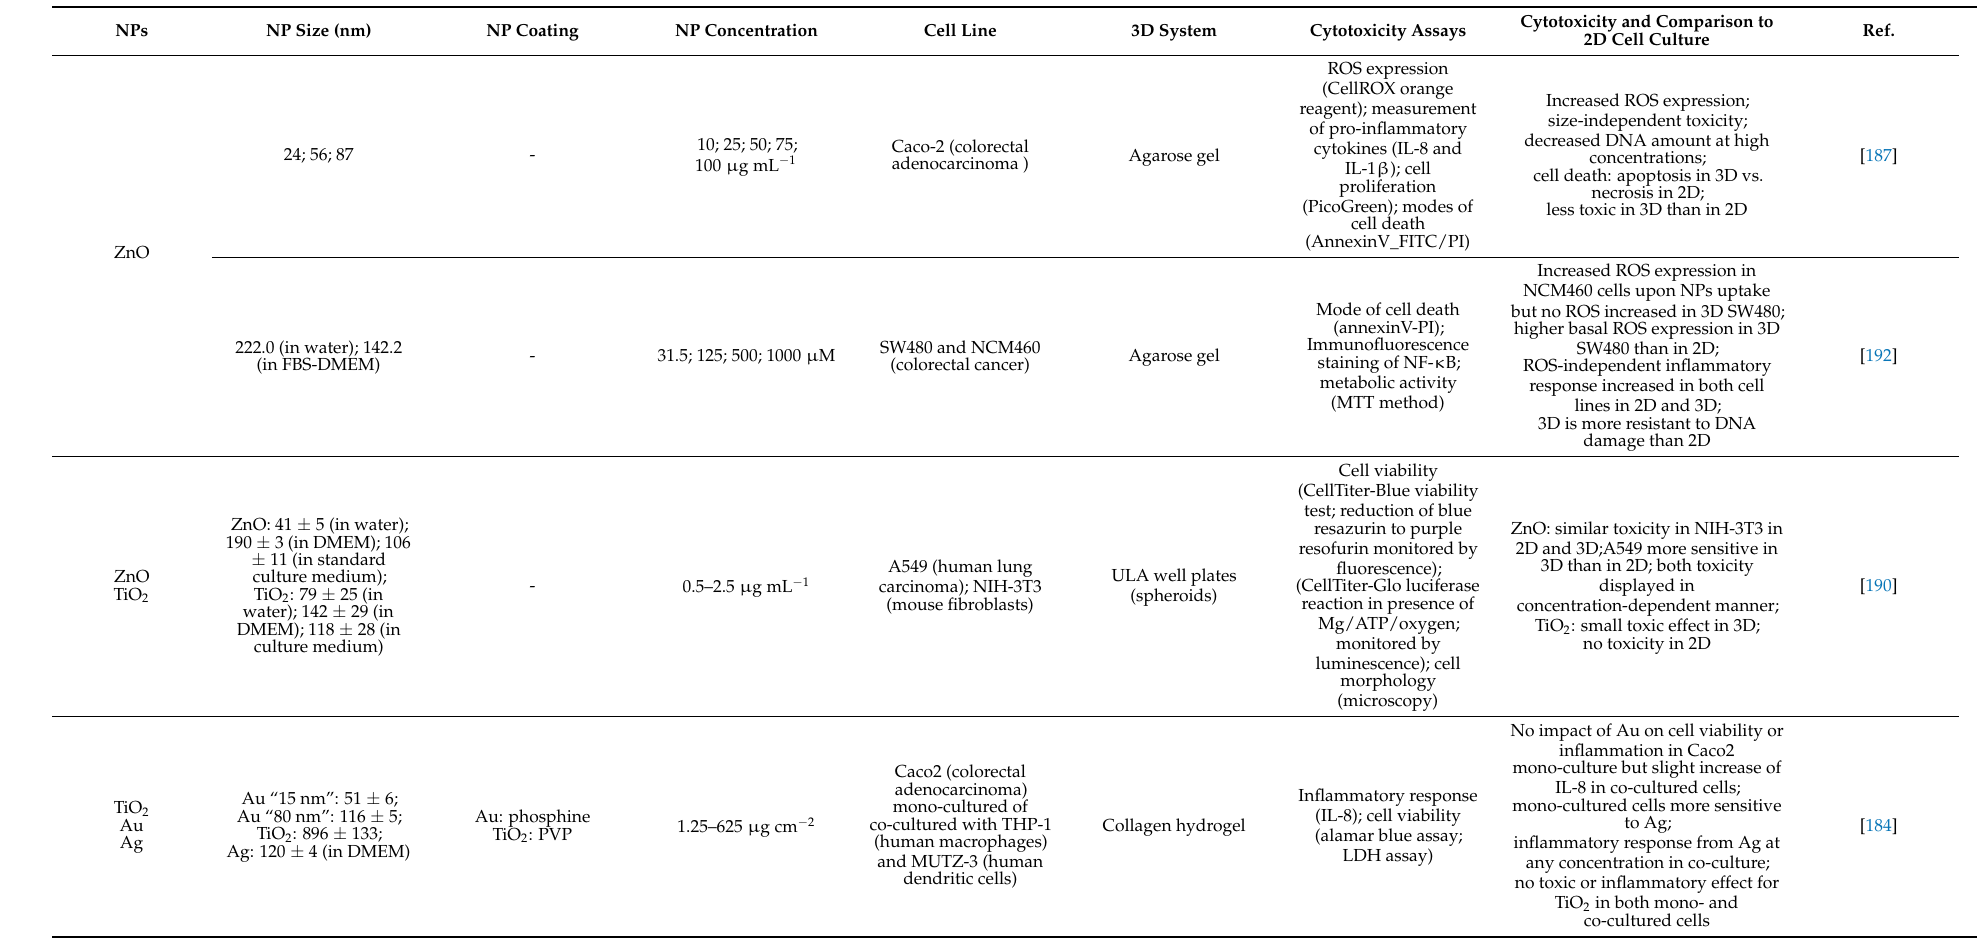
Table 1. Brief of nanoparticles (NPs) toxicity in 2D vs. 3D: cell line/NPs used/3D